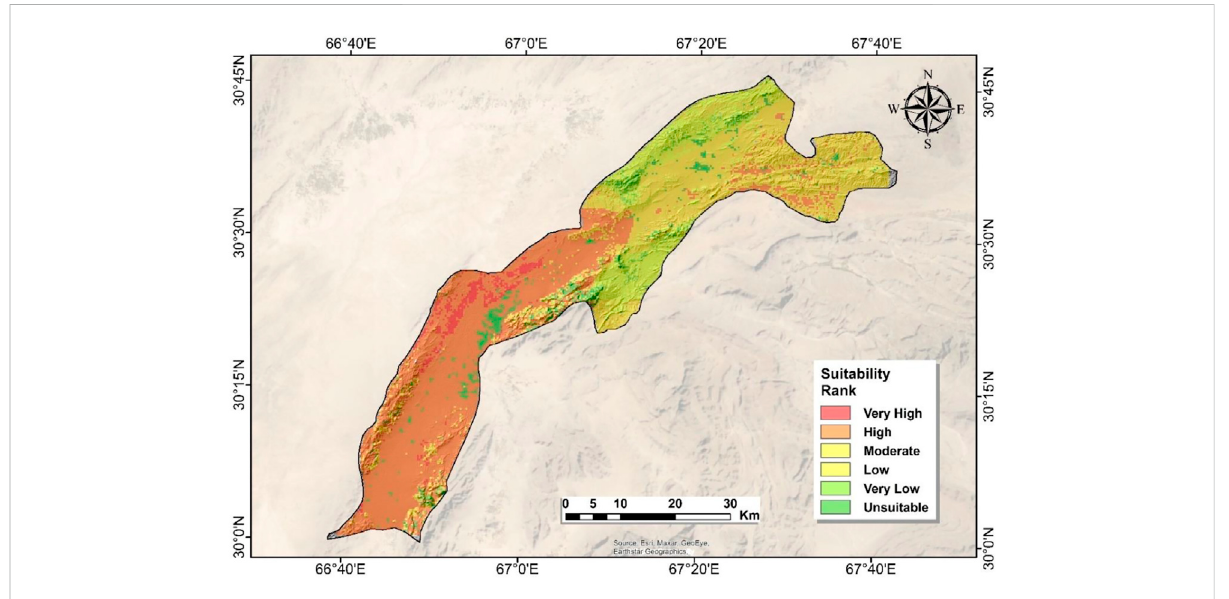
FIGURE 5 MAR suitability map of Kuchlak Sub-Basin, Balochistan,